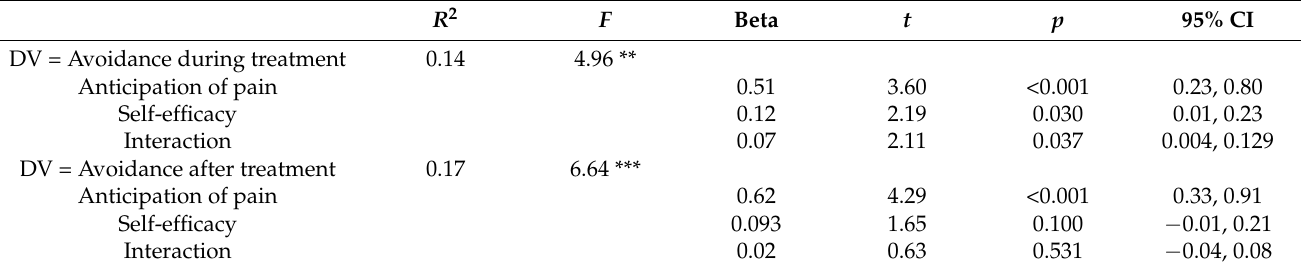
Table 3. Prospective prediction of avoidance during and after treatment from anticipation of pain, self-efficacy, and their interaction.